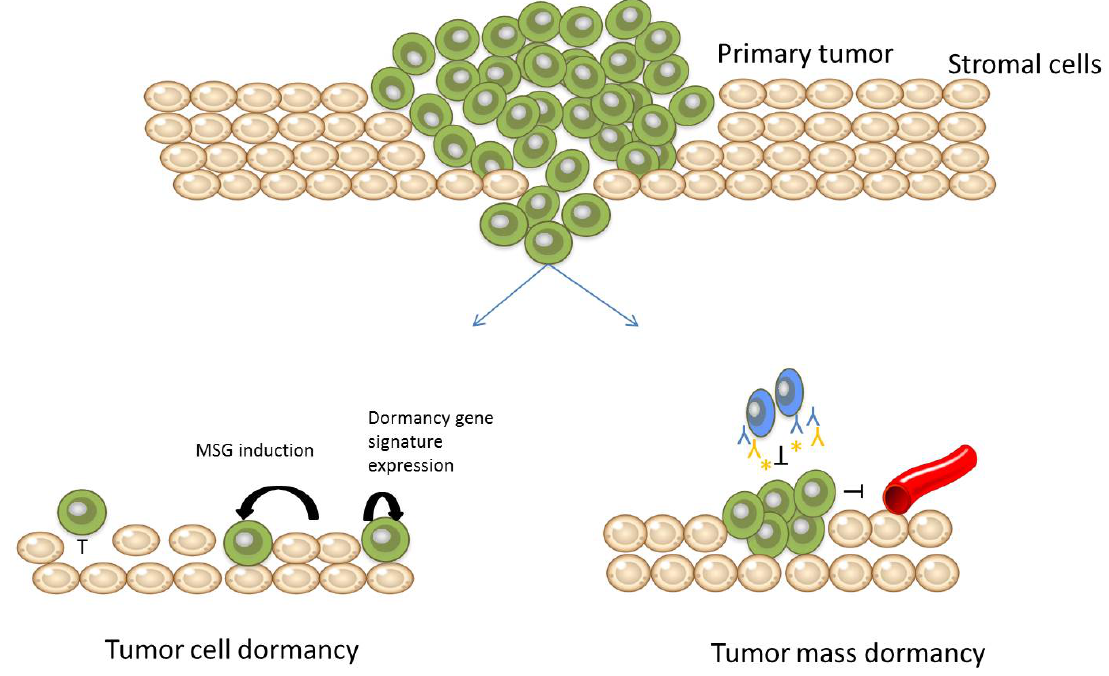
Figure 1. Schematic of metastatic tumor dormancy. Some tumor cells will leave the primary tumor without the ability to proliferate in the new microenvironment and remain as solitary cells (tumor cell dormancy), due to microenvironmental-induced stress, microenvironment incompatibility or even a gene expression profile that is prone to dormancy. Some tumor cells can leave the primary site with the ability to proliferate in the new site, but cannot grow beyond a few mm (tumor mass dormancy) due to immunosurveillance or angiogenic